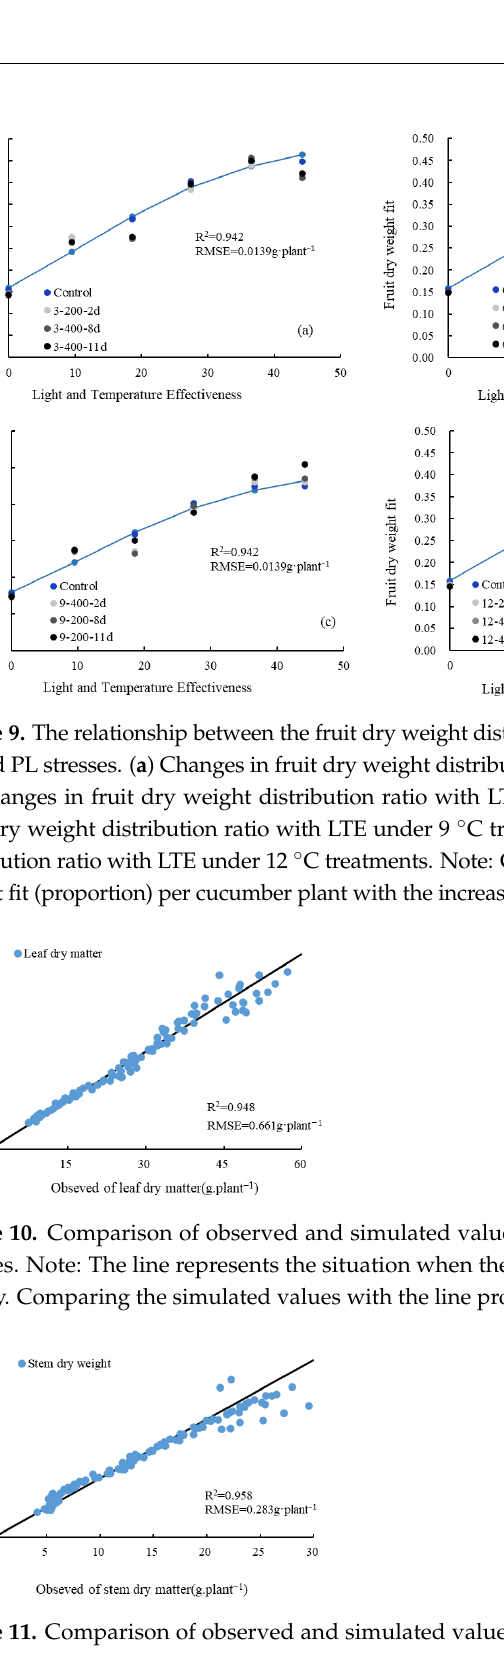
stresses. Note: The line represents the situation when the observed and simulated values coincide